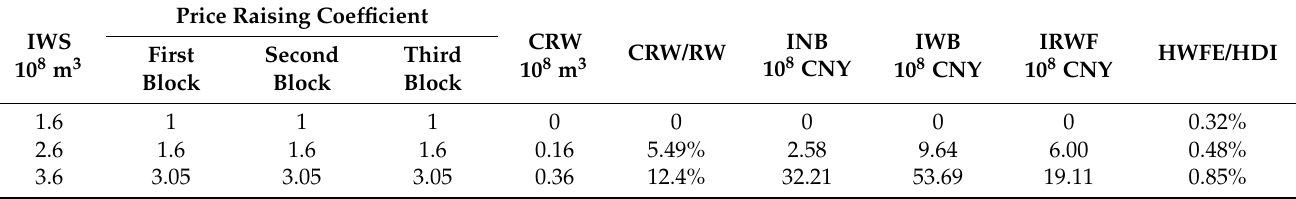
Table 1. Optimization results with three industrial water shortage scenarios.